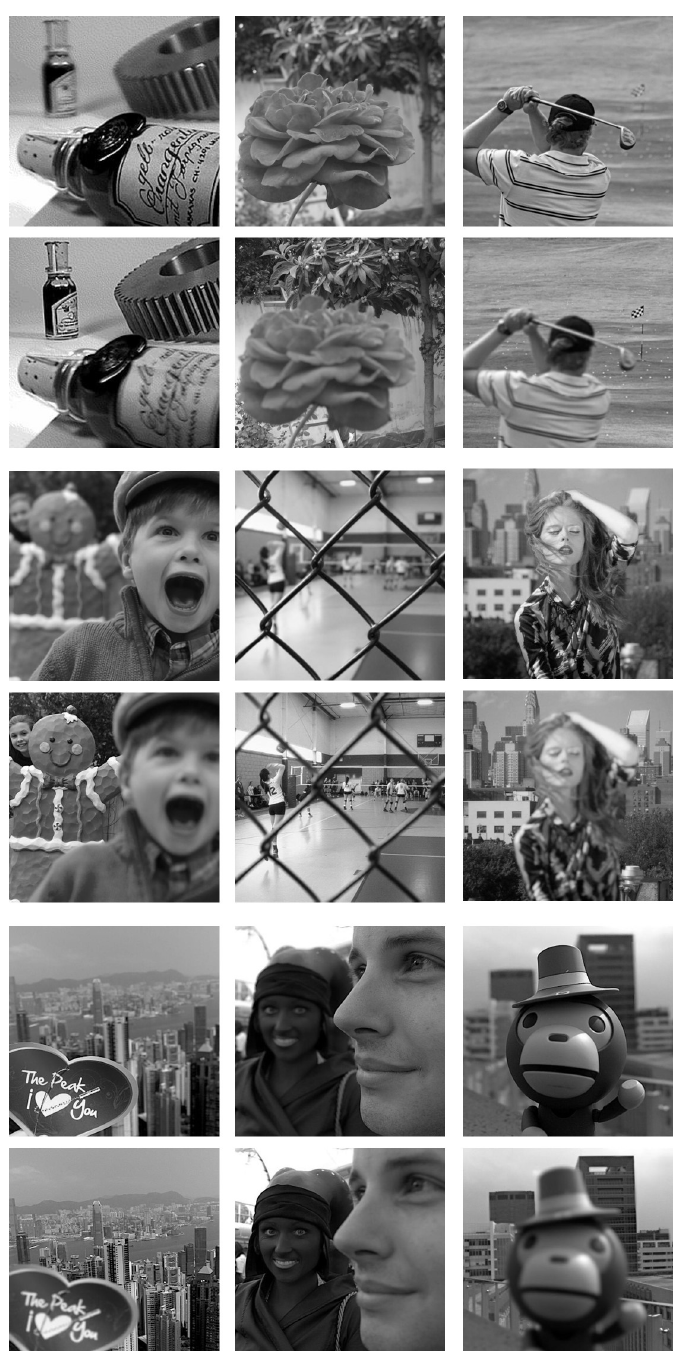
Figure 9. Nine pairs of multi-focus images used for